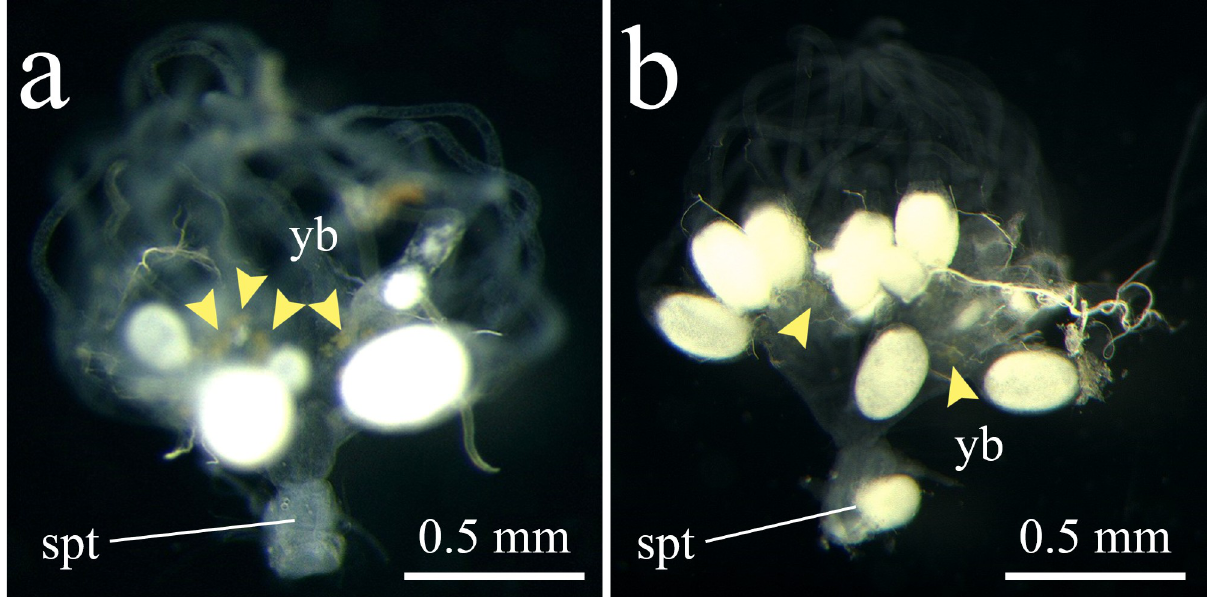
Fig 2. Reproductive organs of (a) Monomorium triviale and (b) M . intrudens queens. (a) M . triviale : Translucent (empty) spermatheca (spt), ovarioles with oocytes and obvious yellow bodies (yb) indicating that virgin queens were reproductively mature and laid eggs. (b) M . intrudens : Opaque (filled with sperm) spermatheca, well-developed ovarioles, and yellow bodies indicating that the queen is sexually reproducing. Yellow arrowheads indicate yellow bodies.